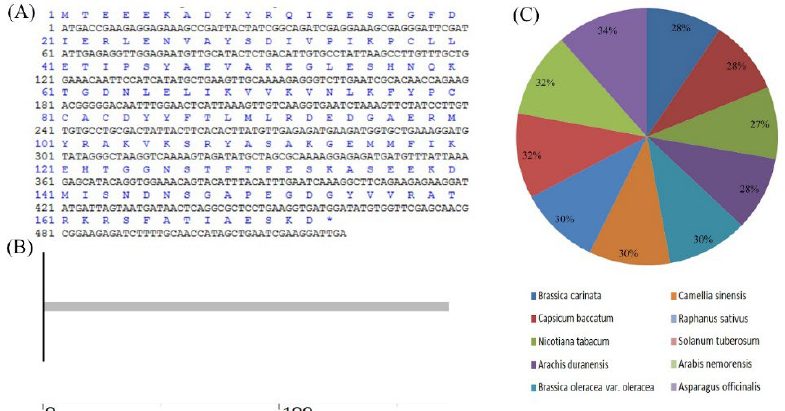
Figure 1. Bioinformatic analysis of Lb1G04202. ( A ) Protein translated by Lb1G04202 . Lb1G04202 contains 522 base pairs and encodes 173 amino acids. ( B ) Structural prediction of